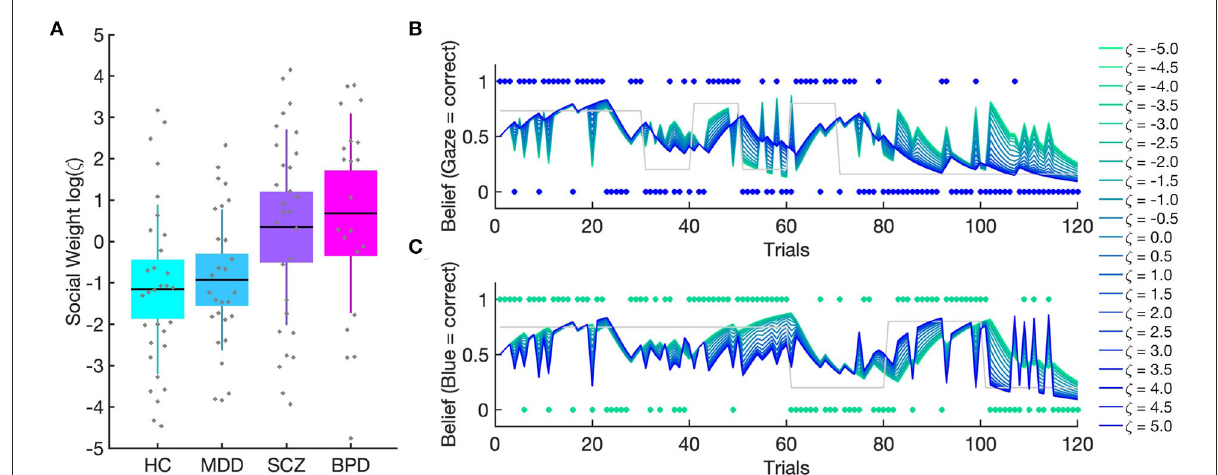
FIGURE1 (Taken from: Henco et al., 2020). (A) Patients with borderline personality disorder (BPD) and schizophrenia (SCZ) gave social information more weight compared to healthy controls (HC) and patients with major depressive disorder (MDD). Boxes mark 95% confidence intervals and vertical lines standard deviations. (B) Simulations demonstrate the impact of varying weighting factor on combined belief. (B) shows that the combined belief of agents with high zeta values is aligned with the social input structure (blue dots) whereas these agents show a stochastic belief structure with regard to the non-social input structure (green dots) in (C) . Conversely, agents with low zeta values show a belief structure more closely aligned with the non-social input structure and a stochastic belief structure with regard to the social input as shown in (B)